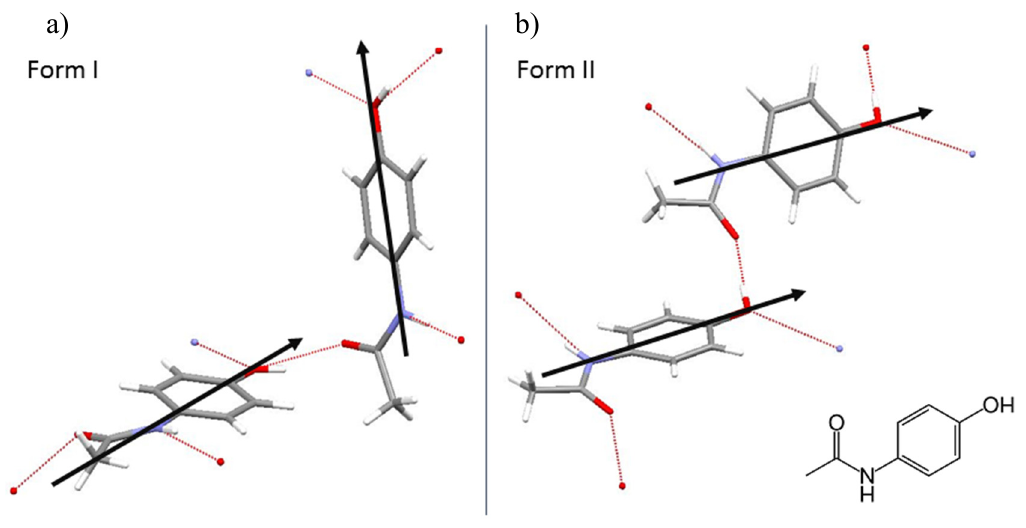
Figure 2. Synthons in the crystal structure of paracetamol, form I exhibiting hydrogen bond orthogonal to each other; whereas form II with a parallel arrangement of molecules participating in a hydrogen bond. Inset: Paracetamol.